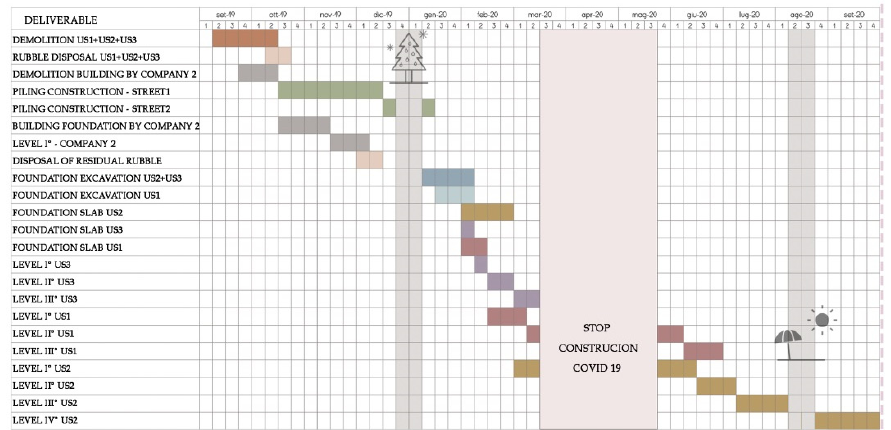
Figure 13. Deliverable programming—Model Smart Management.